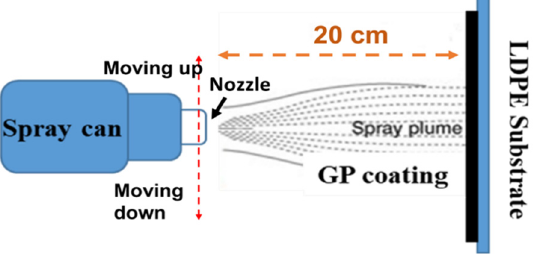
Figure 1. Scheme of the apparatus used for the spray deposition technique .